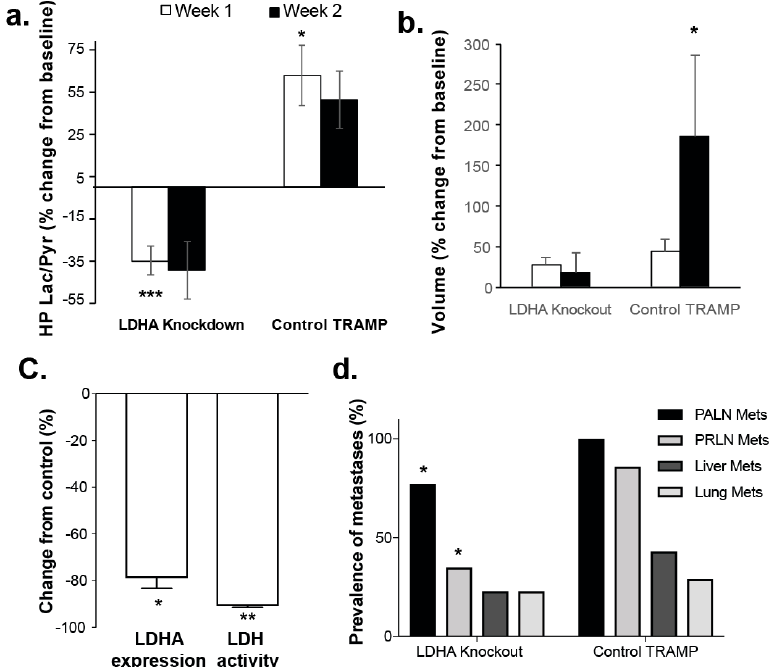
Figure 6. ( a ) Graphical presentation showing the mean ± sdev % changes in the HP Lac/Pyr from baseline of tamoxifen (LDHA-knockout), or vehicle control (LDHA-intact). ( b ) Corresponding mean ± sdev % volume changes from baseline. ( c ) Mean ± sdev % change from control of in Ldha expression and LDH activity in Ldha -knockout mice. ( d )% prevalence of metastasis in control TRAMP to that in Ldha -knockout mice, concentrating on several typical sites of disease spread: regional lymph nodes (PALN), the more distant lymph nodes (PRLN), and visceral metastases (liver and lung). * denotes p < 0.05, ** for p < 0.005, *** for p < 0.0005.